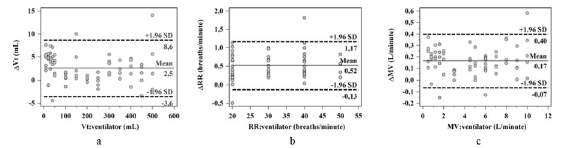
Fig. 1 Bland‑Altman plots of phantom’s quantitative measures. The plots are showing the agreement between the gold‑standard method (ventilator) and our method (3D system) in estimating Vt (a), RR (b), MV (c) quantitative measures Reference